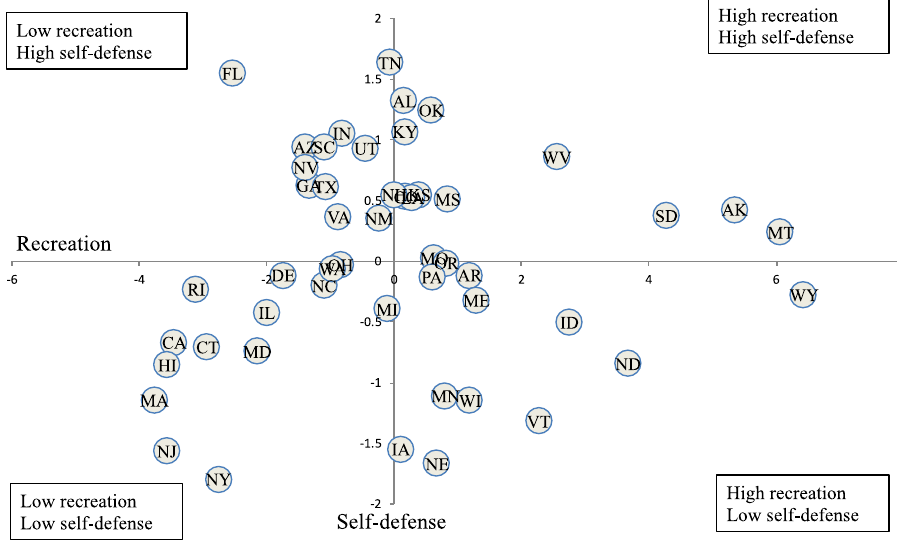
Fig. 3 Mix of state subcultures: Recreation/Self-Defense. Standardized component scores (representing the difference for a particular state from the mean for all states expressed in number of standard deviations) are shown for Recreation on the x -axis and for Self-Defense on the y -axis.